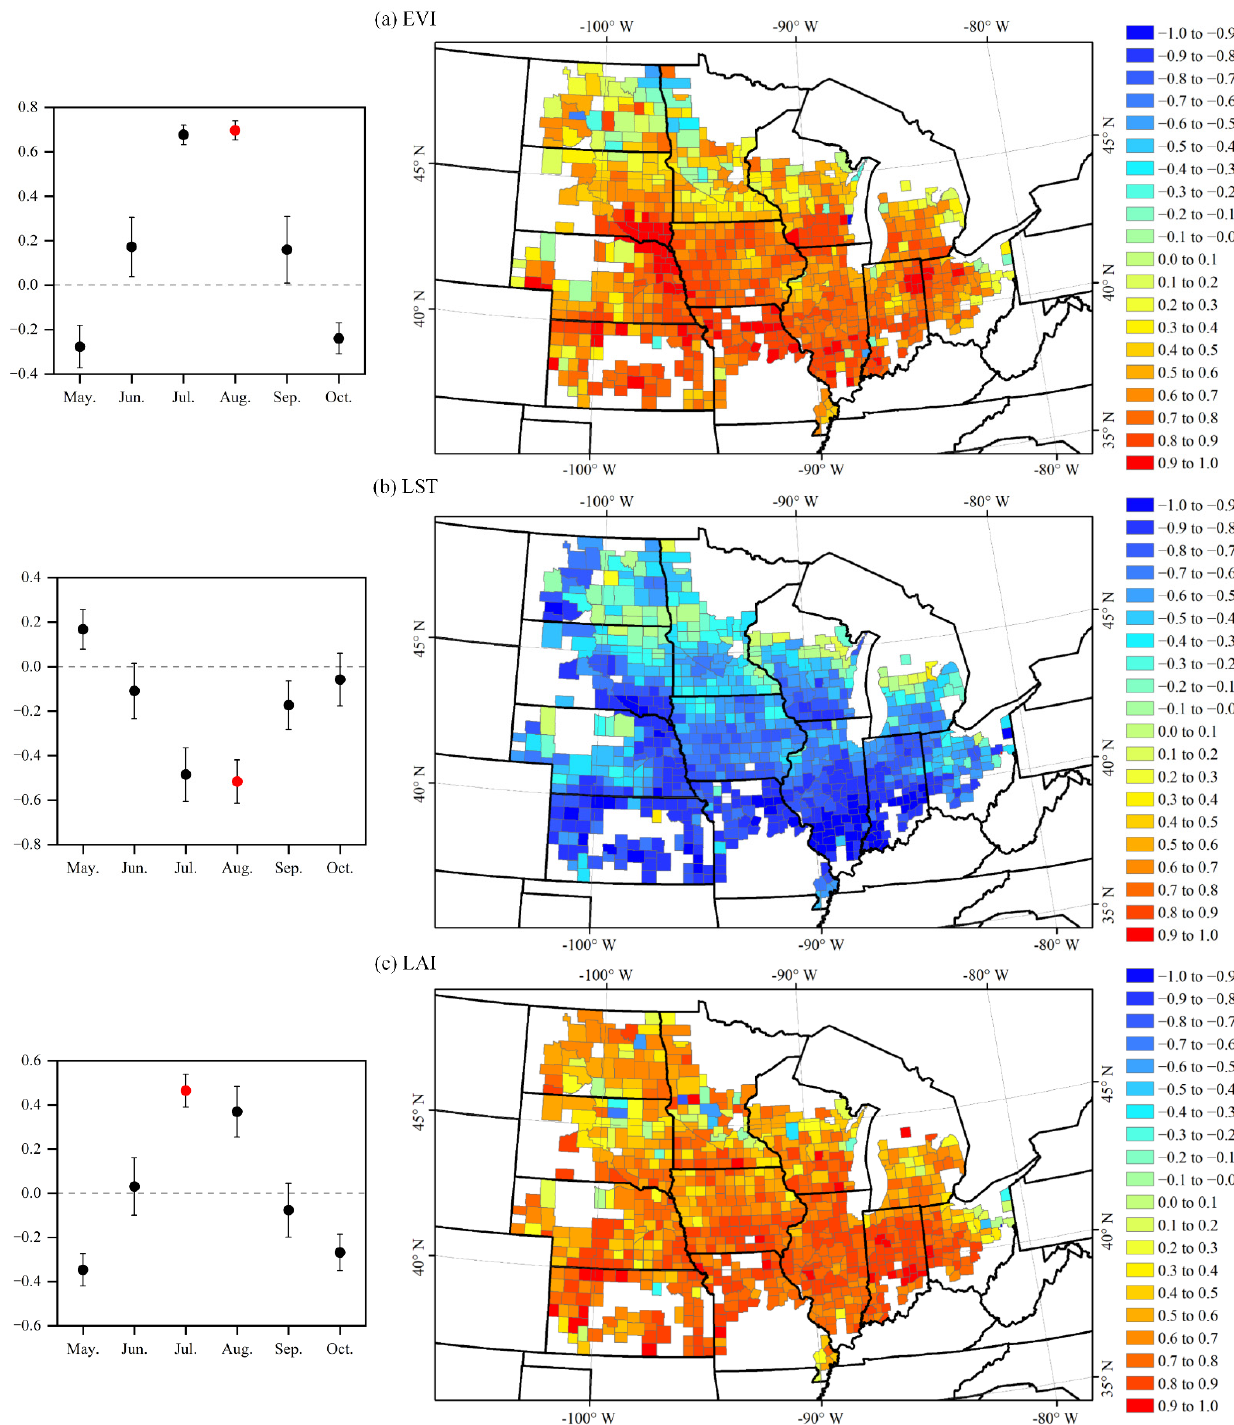
Figure 2. Changes in the spatiotemporal correlations (r values) between monthly values for satellite- derived indices during the GS and corn yield (( a ) − EVI, ( b ) − LST and ( c ) − LAI). The left panel is the temporal pattern of the correlation between indices and corn yield. The right panel is the spatial pattern of the correlation between indices and maize yield, and the indices are the indices for the months with the largest correlation with corn yield in the temporal pattern (the red dots).